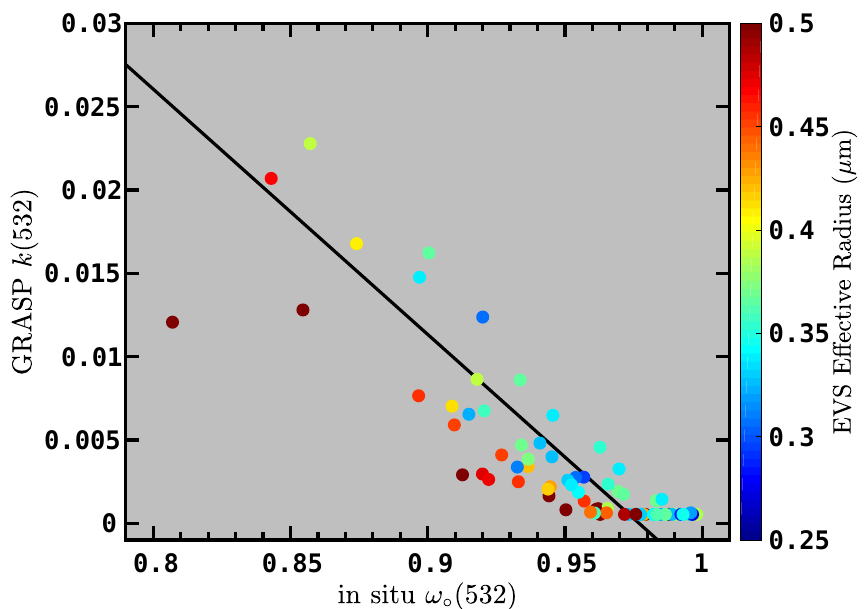
Figure 12. Imaginary refractive index for 89 samples that have residuals σ ≤ 8%, plotted against single-scatter albedo (measured with CAPS extinction and PSAP absorption). Data are color-coded with the effective radii of equivalent volume spheres (EVSs) computed from aerodynamic size using the method outlined in Section 4.3 to obtain dynamic shape factors. A simulated solar zenith angle of θ ◦ = 50 ◦ was used for the GRASP imaginary index retrieval. Solid line is a linear regression with correlation coefficient of cc = − 0.9092. Please note that the color code indicates that ω ◦ tends to decrease with respect to R ef f for a given k